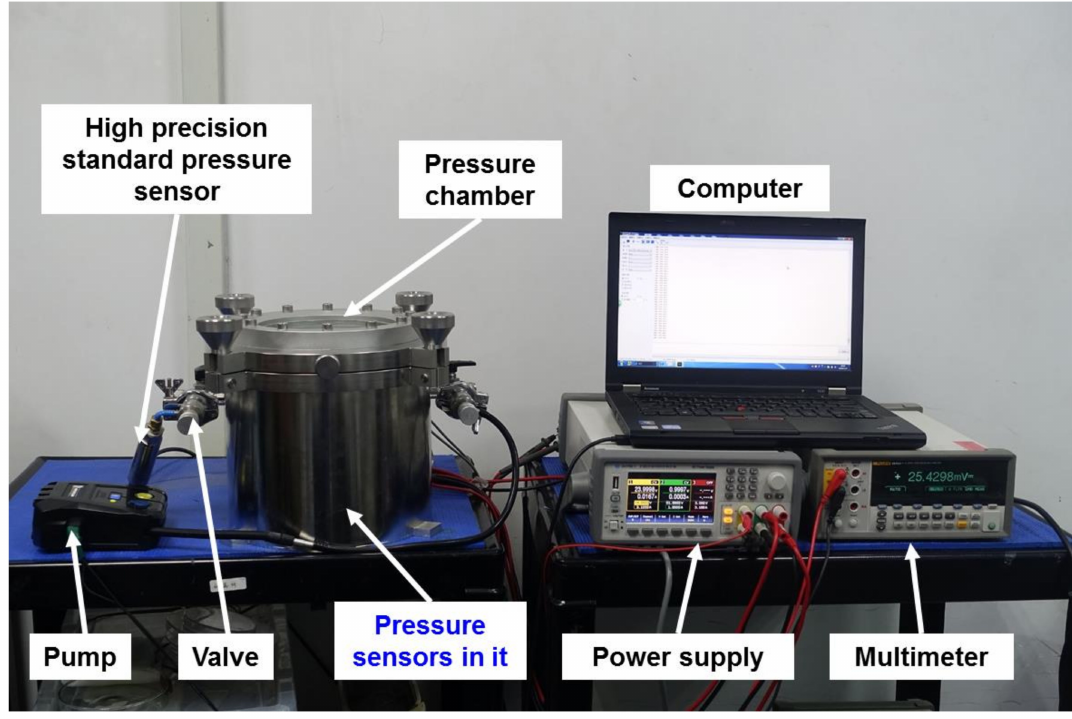
Figure 3. Photograph of the pressure sensor test